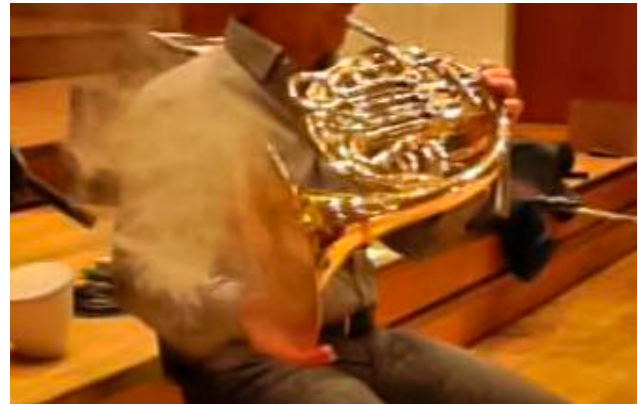
Figure A5. Artificial fog at the bell of the horn.